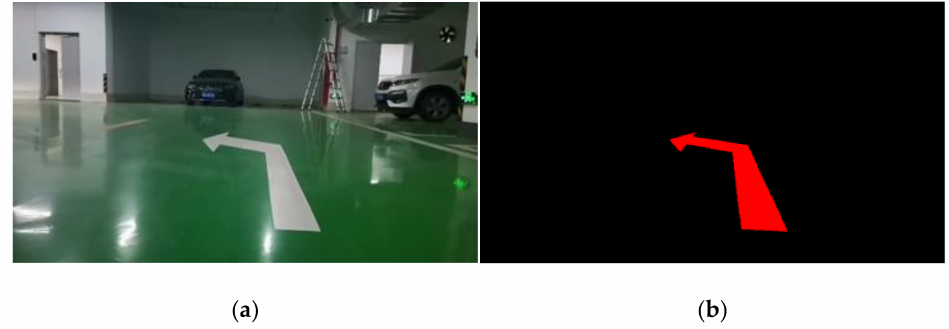
Figure 14. Before and after lane line detection. ( a ) Image to be detected. ( b ) Renderings of lane line detection.